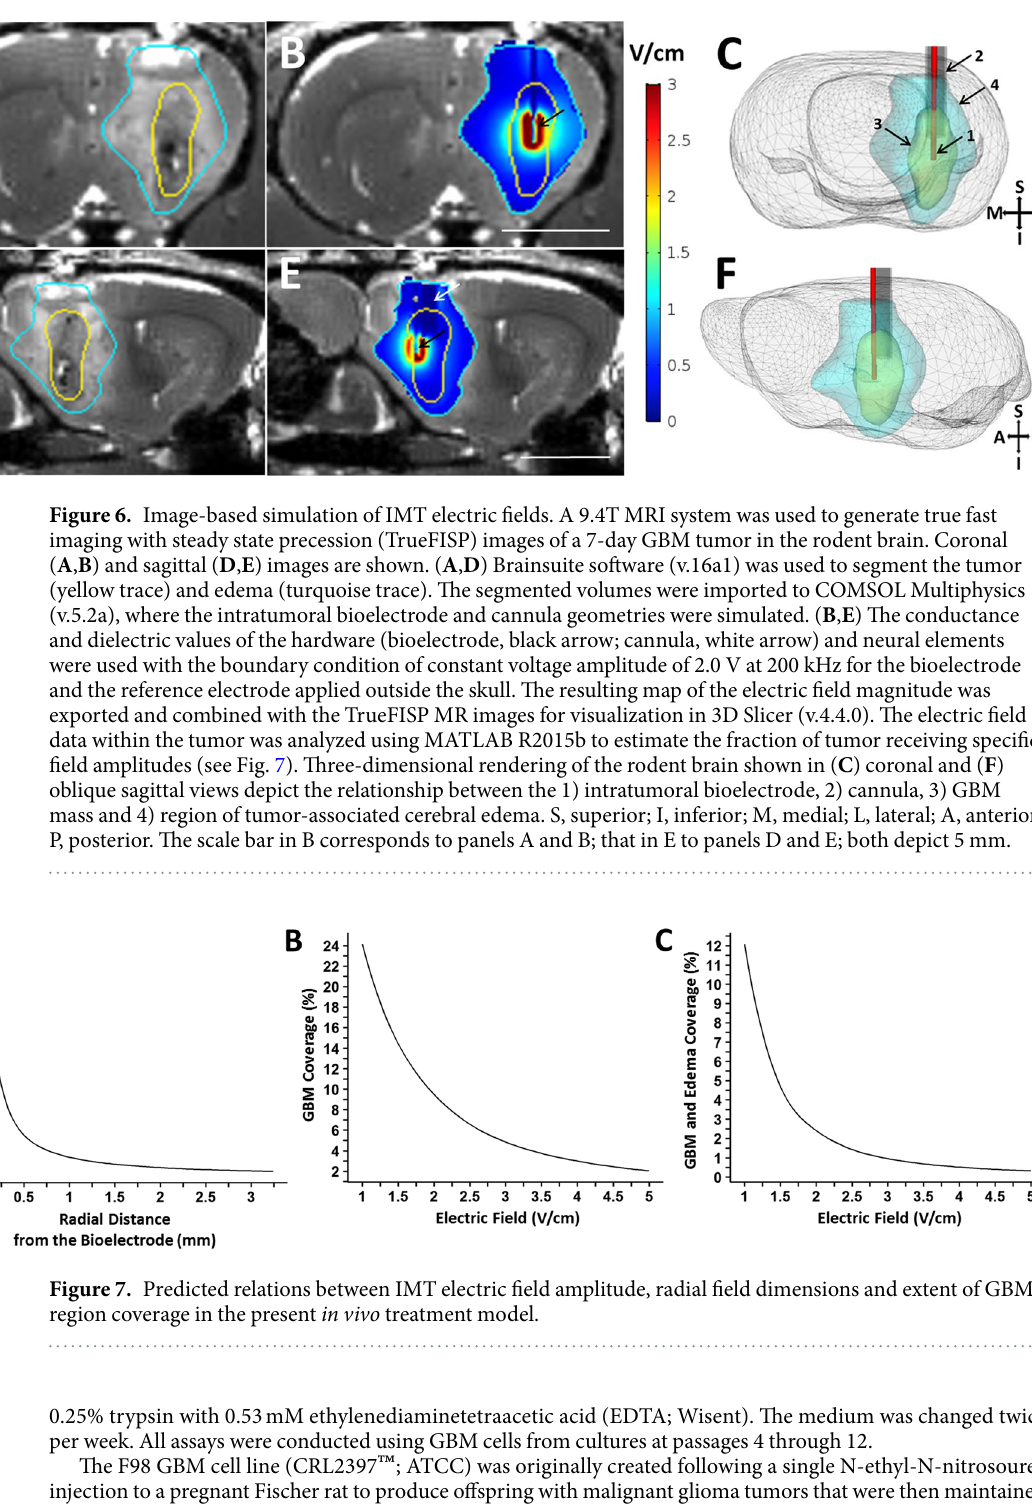
0.25% trypsin with 0.53 mM ethylenediaminetetraacetic acid (EDTA; Wisent). The medium was changed twice per week. All assays were conducted using GBM cells from cultures at passages 4 through 12. The F98 GBM cell line (CRL2397 ™ ; ATCC) was originally created following a single N-ethyl-N-nitrosourea injection to a pregnant Fischer rat to produce offspring with malignant glioma tumors that were then maintained in culture 22,23 . The low immunogenicity of F98 cells in syngeneic Fischer rats offers advantages over xenogeneic and allogeneic models that require immunosuppression or may exhibit spontaneous tumor regression. F98 GBM tumors are highly proliferative, invasive and recalcitrant to conventional therapies, closely mimicking the human disease. F98 cells were cultured in 100 mm dishes in DMEM supplemented with 10% FBS, 1% non-essential amino acids and 1% penicillin/streptomycin (Life Technologies) in a humidified incubator at 37 °C with 5% CO 2 . The medium was changed twice per week and cultures passaged at ~80% confluence and split 1:2 using 0.25% trypsin with 0.53 mM EDTA (Wisent). Primary neuronal cultures. IMT was evaluated in post-mitotic primary neurons isolated from embryonic rat brains (N = 3). Cerebral cortices from E18 Wistar embryo were dissected into a 14 ml conical tube containing